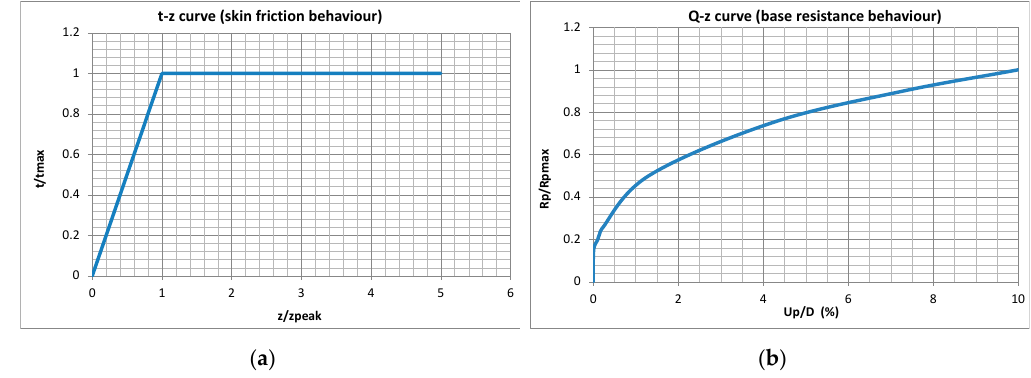
Figure 8. Pile deformation parcial relaptionship ( a ): t-z curves. ( b ) Q-z. curves.